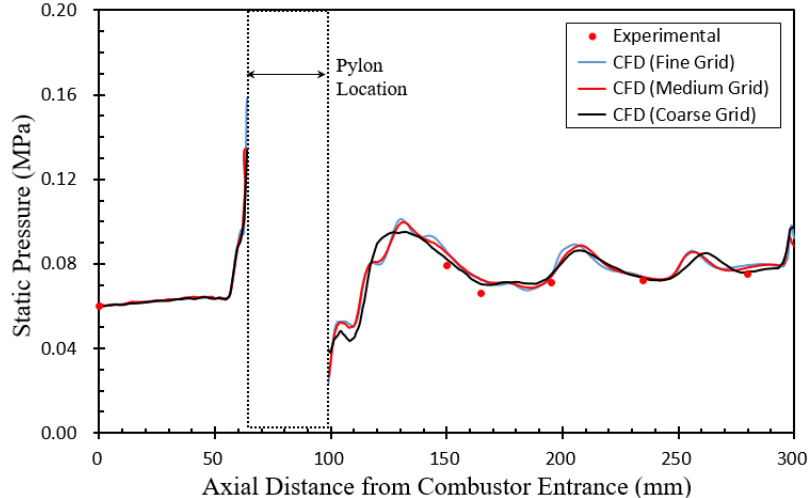
Figure 2. Comparison of static pressures along the center of combustor top wall for three different grids with experimental data [33].